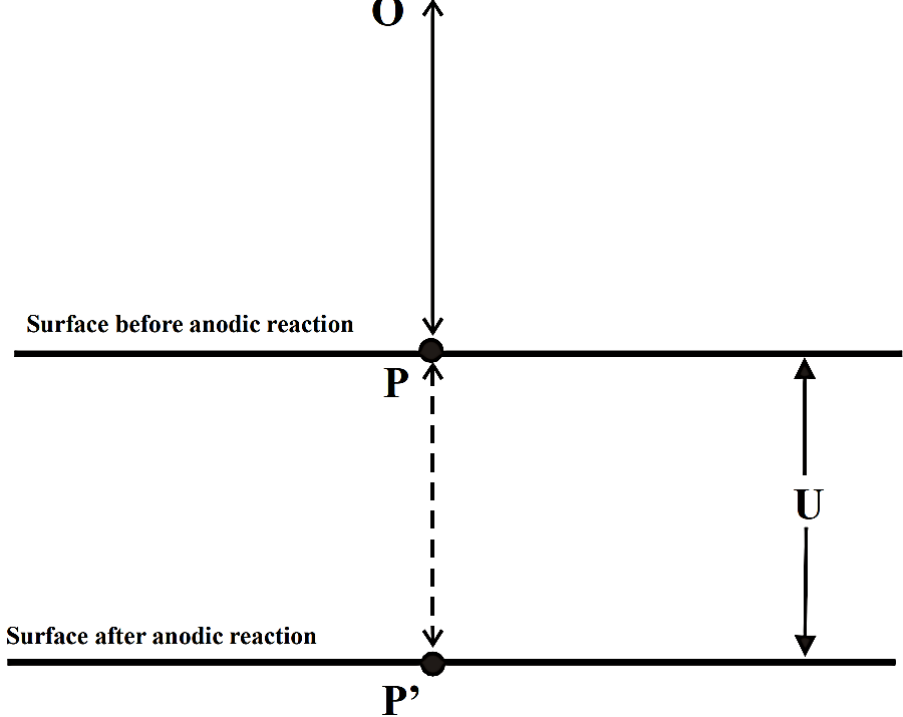
Figure 18. Effect of corrosion on path length of light used in interferometry. (Reprinted from ref. [68]).